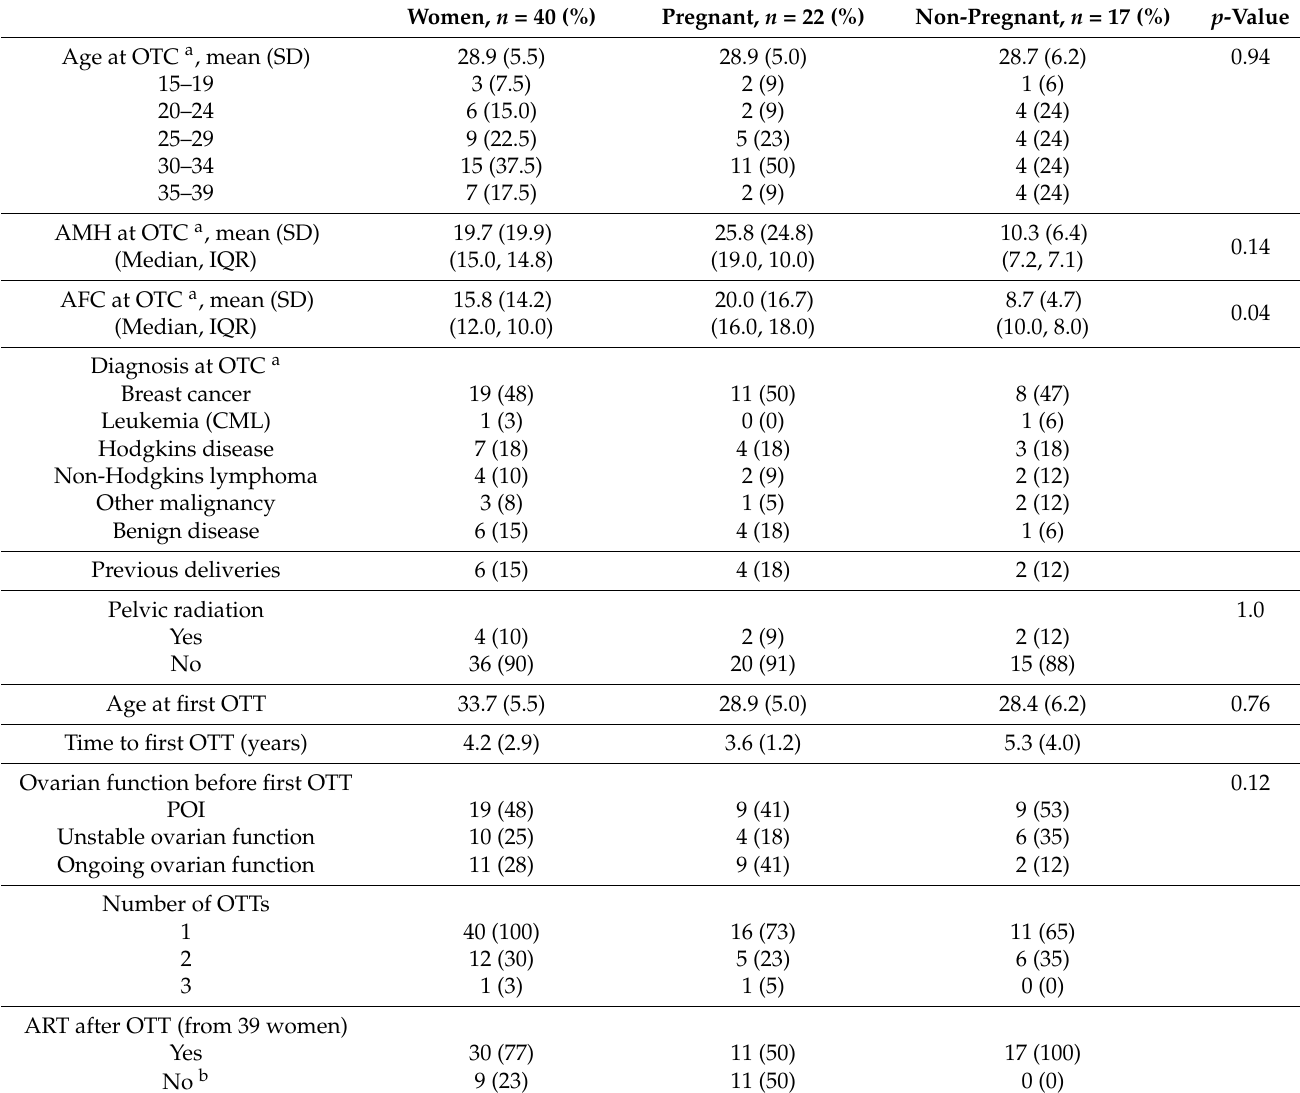
Table 1. Characteristics of women going through ovarian tissue transplantation, overall and with/without